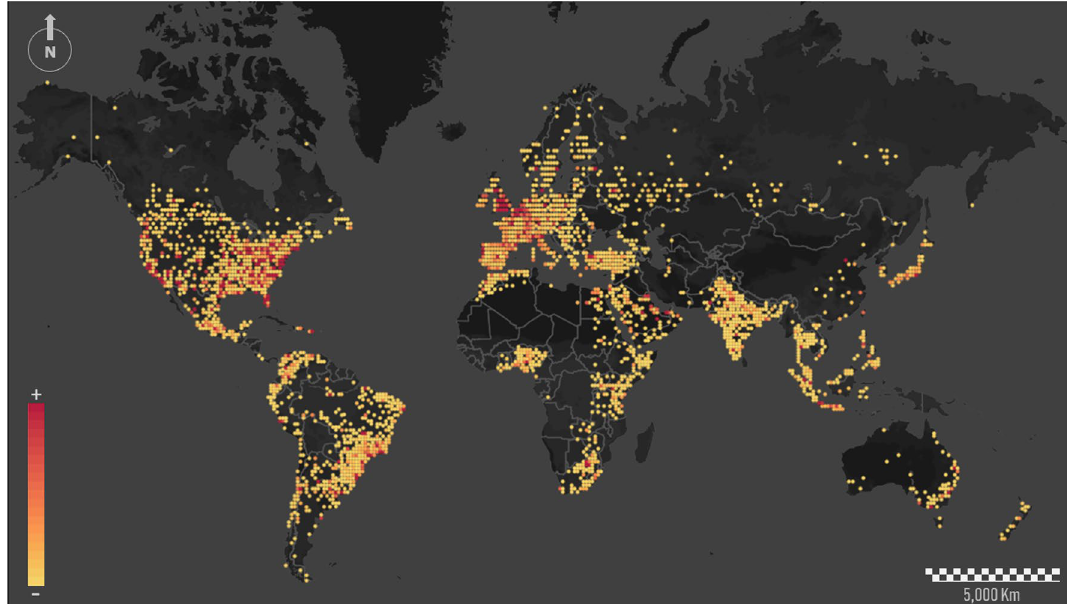
Figure 1. Global heatmap showing tweets location. Main hotspots are shown in red. This figure was generated using ArcGIS Desktop and